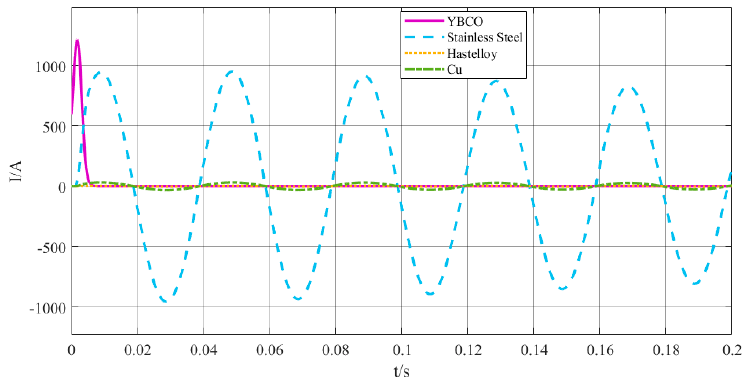
Figure 8. The current of each